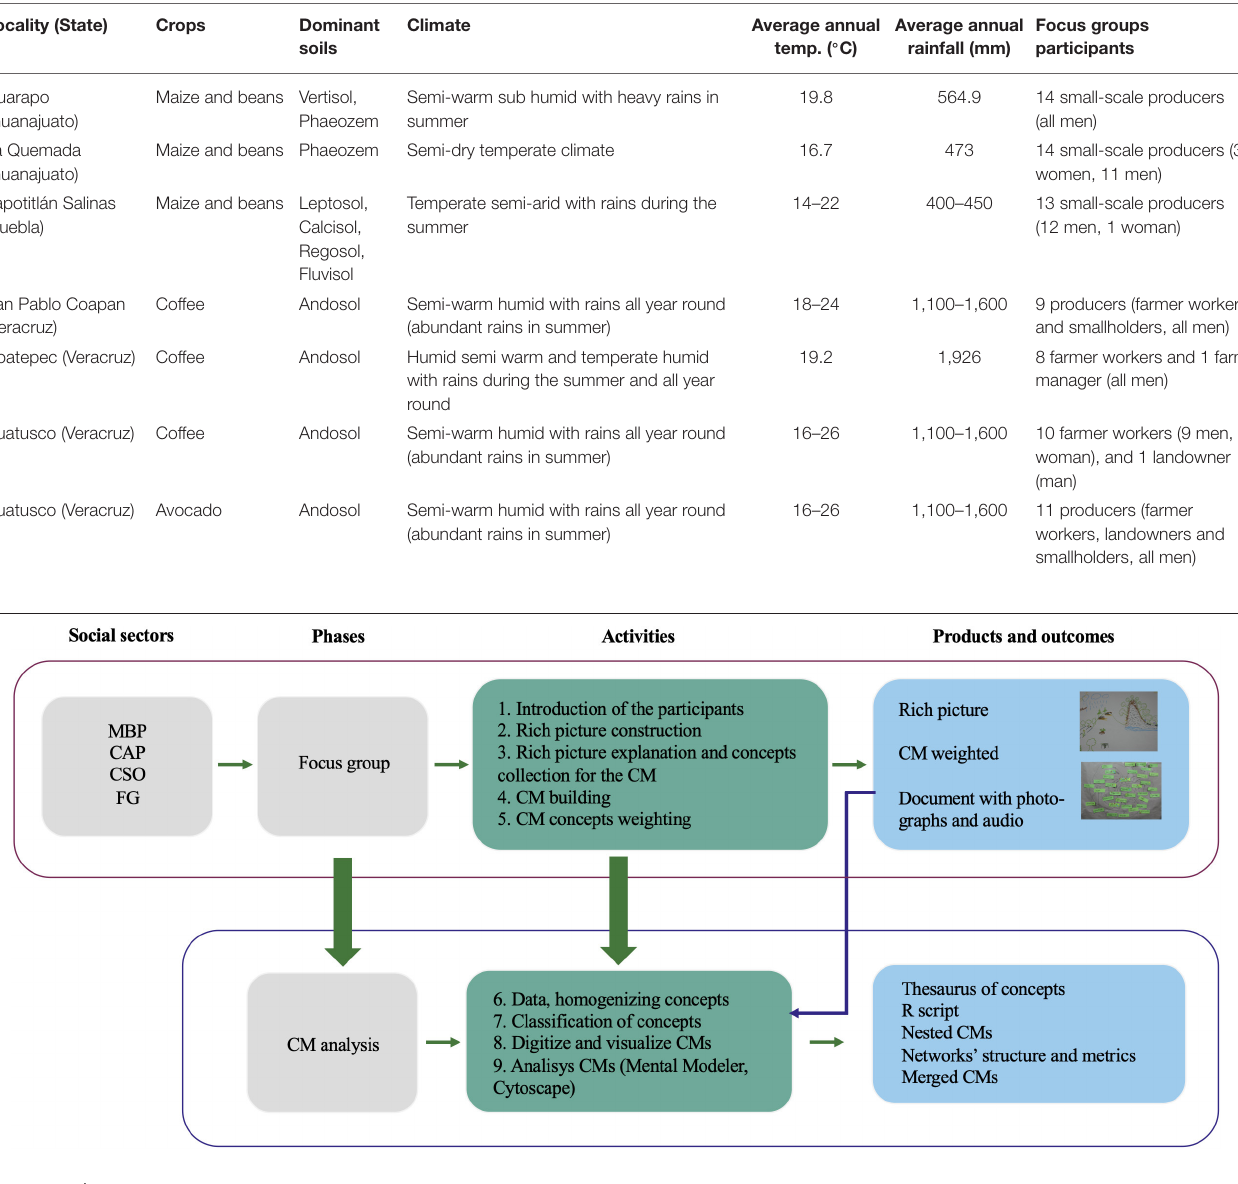
TABLE 1 | Main characteristics of the six localities where focus groups with local food producers were conducted. Locality (State)